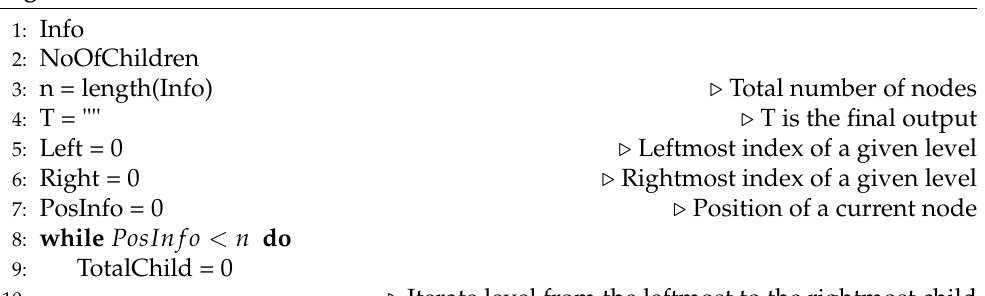
Algorithm 1 Traversal on